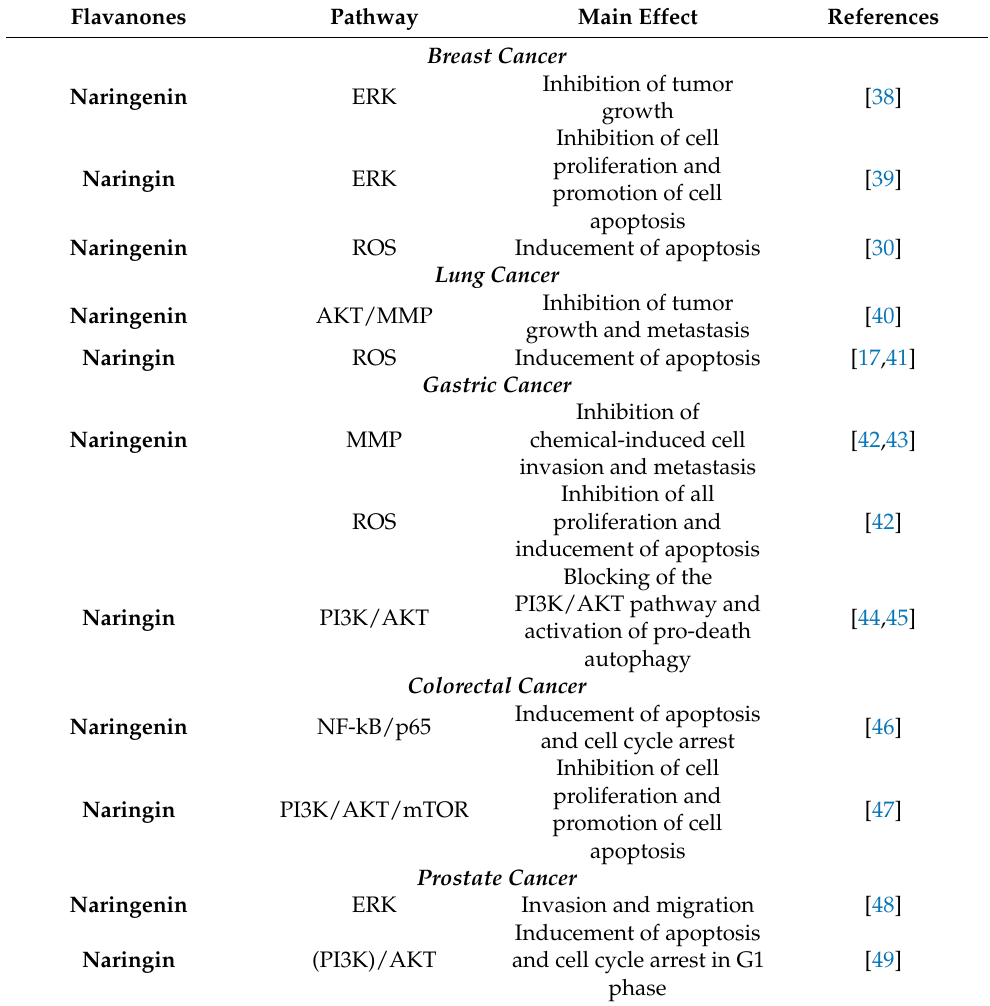
Table 1. The main anticancer effects of naringin and